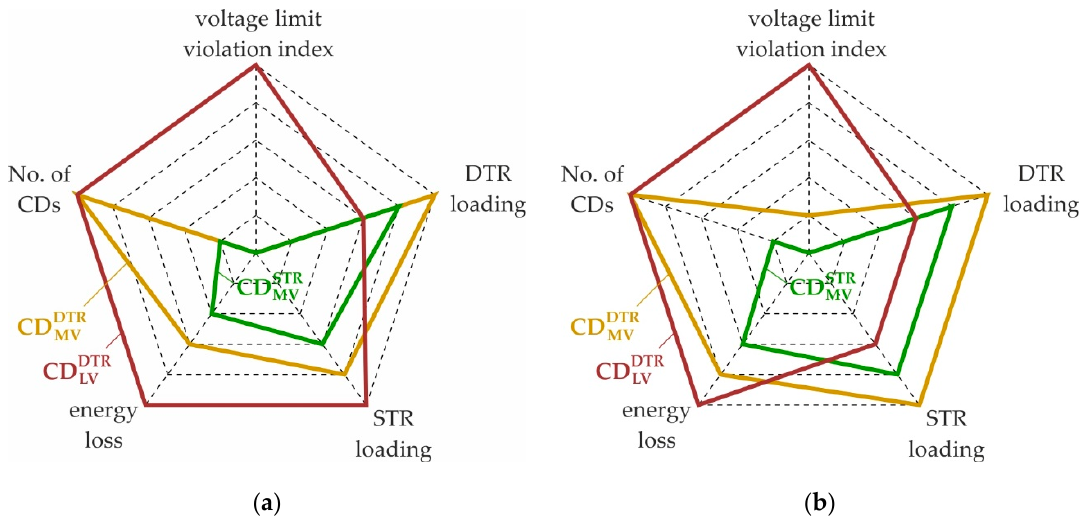
Figure 15. Qualitative representation of the criteria used for the evaluation of various CD placements